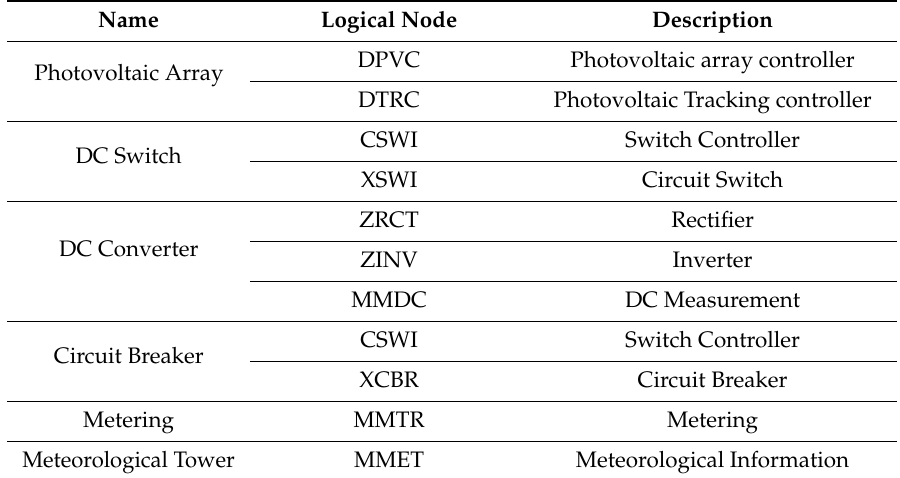
Table 4. List of logical nodes associated with photovoltaic system based on IEC 61850-7-420.